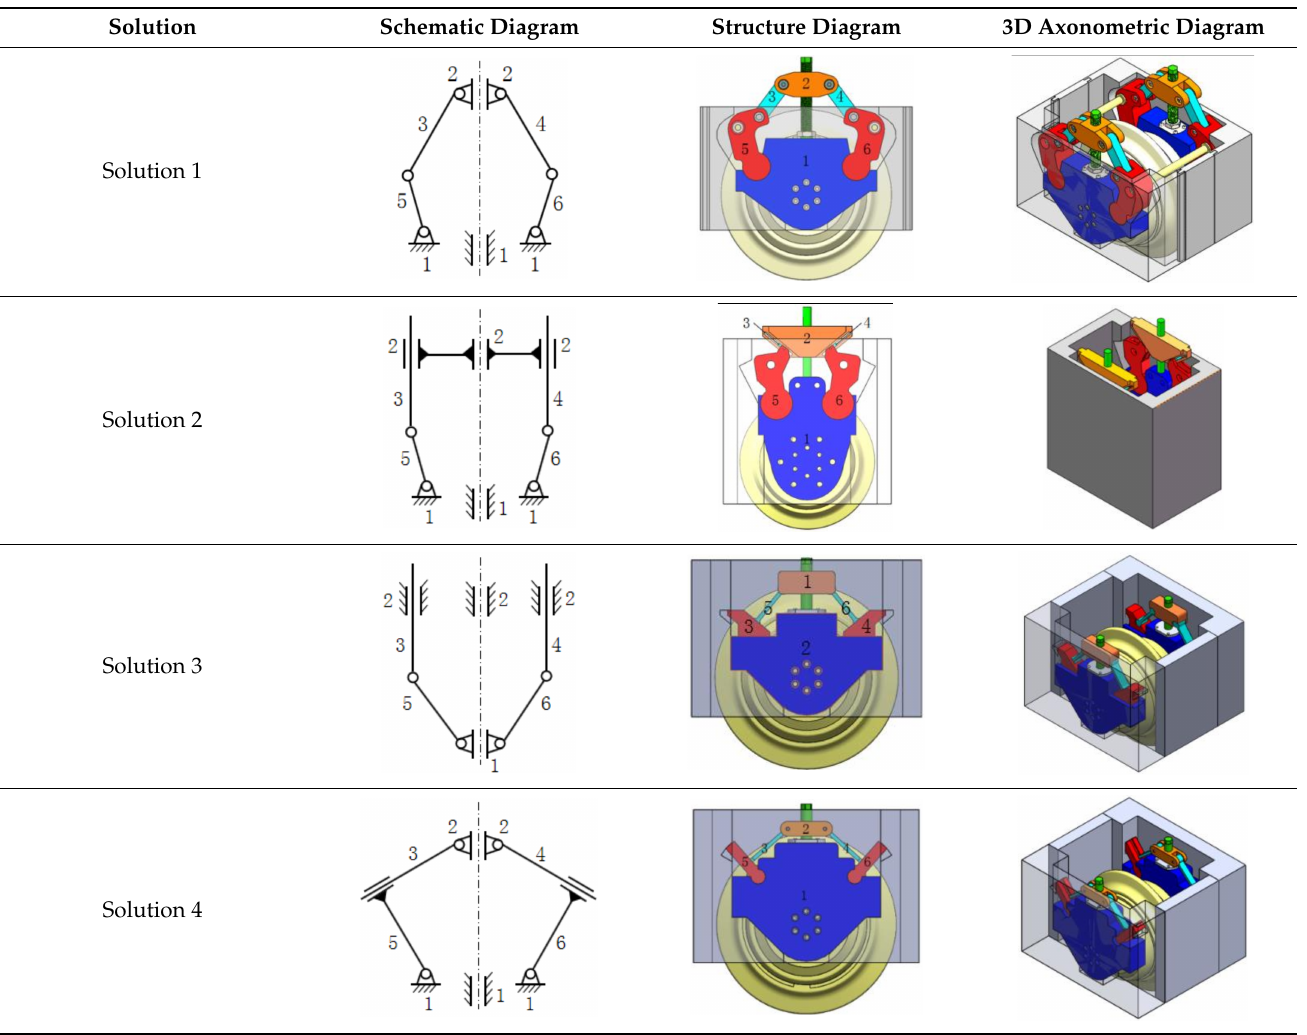
Table 2. Four ICS